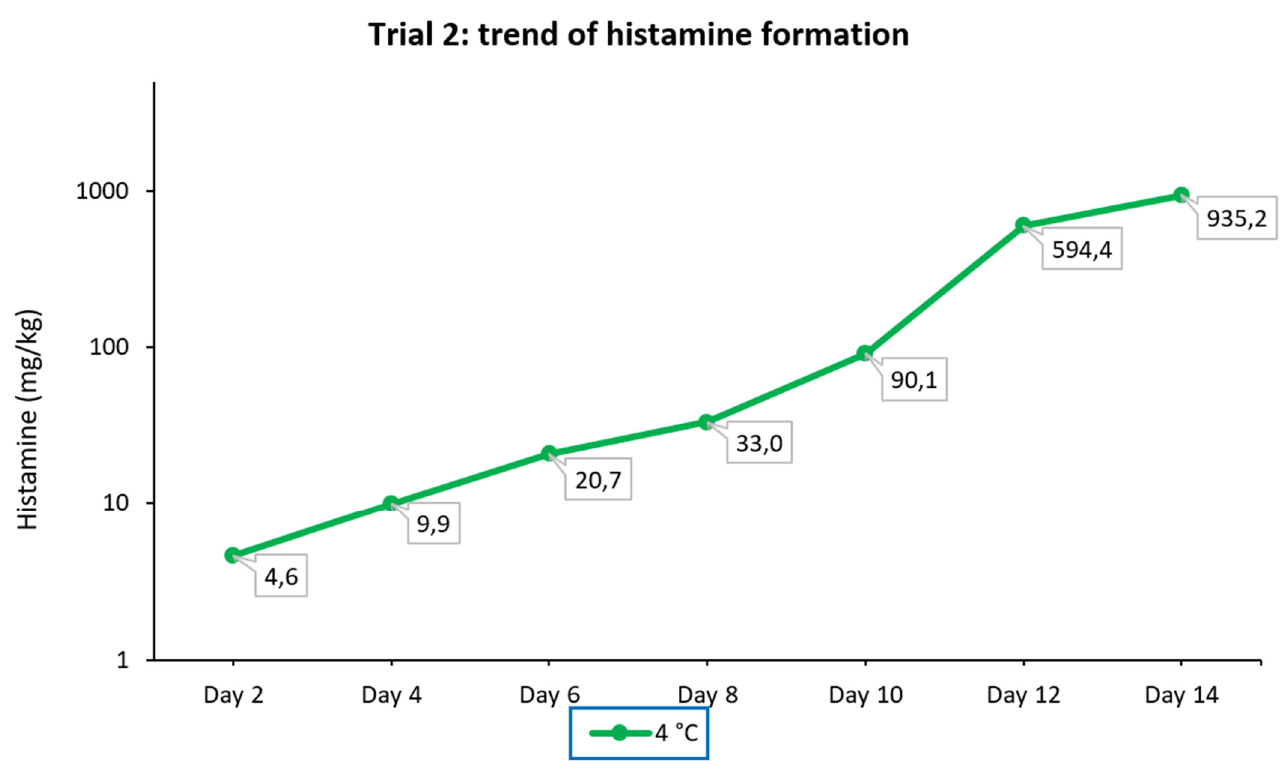
Figure 4. Trend of histamine formation over fourteen consecutive days in fresh tuna samples grafted with tuna muscle naturally incurred with histamine, submerged in corn seed oil (anaerobic condi- tion), and stored at 4 °C (trial 2). The ordinate is scaled